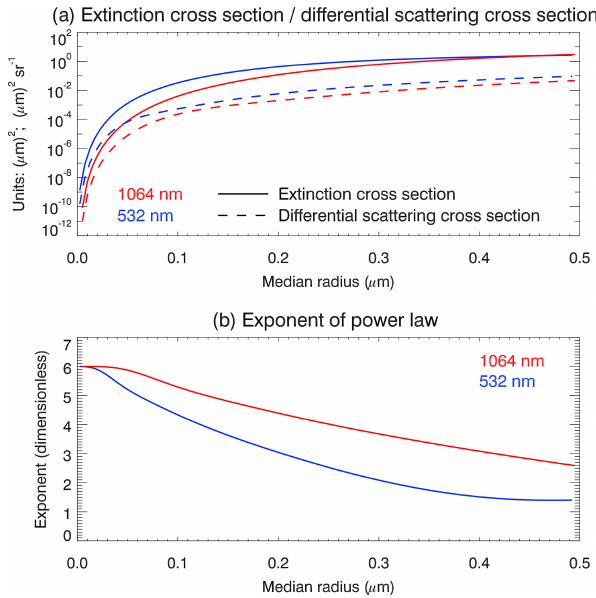
Figure 1. (a) The solid lines correspond to the median radius depen- dence of the Mie extinction cross section at 1064nm (red line) and 532nm (blue line) for a monomodal log-normal particle size dis- tribution with S = 1 . 4. The dashed lines display the median radius dependence of the differential scattering cross section for a lidar backscatter geometry. (b) Dependence of the power law exponent (see Eq. 4) of the dependence of the aerosol extinction cross section on the median